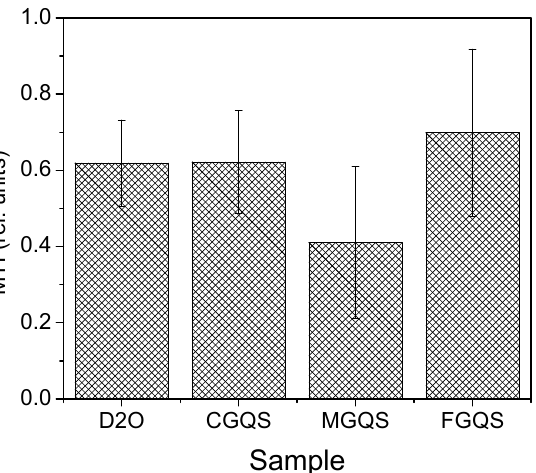
Figure 3. MTI values calculated for the indicated samples according to Rel. (2); estimated standard deviations are indicated.